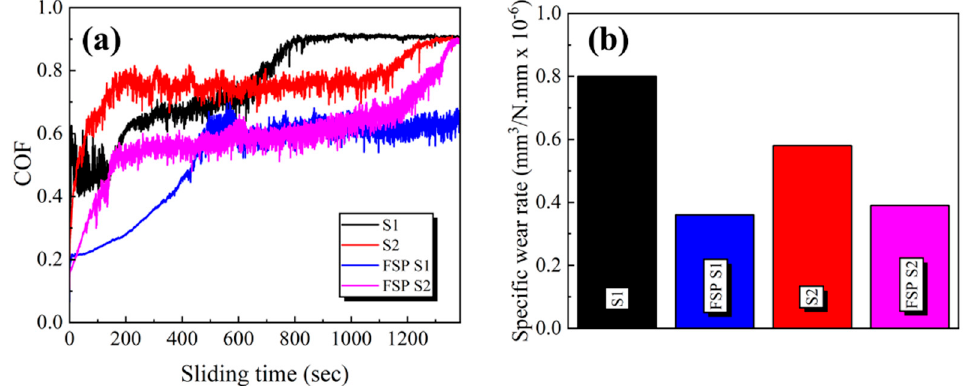
Figure 11. ( a ) Variation of coefficient of friction as a function of time, and ( b ) specific wear rate for a regular load of 2N of all developed coatings.